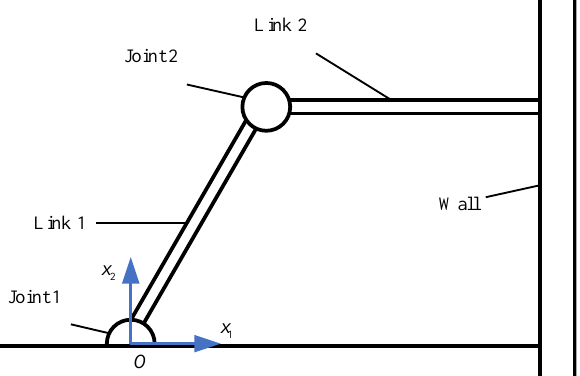
Figure 5. The scene of the wall-contacting task. The two-link robot with two revolute joints needs to keep a constant contact force while moving along a wall with unknown stiffness. x 1 is the direction toward the inside of the wall, and x 2 is the direction upward along the